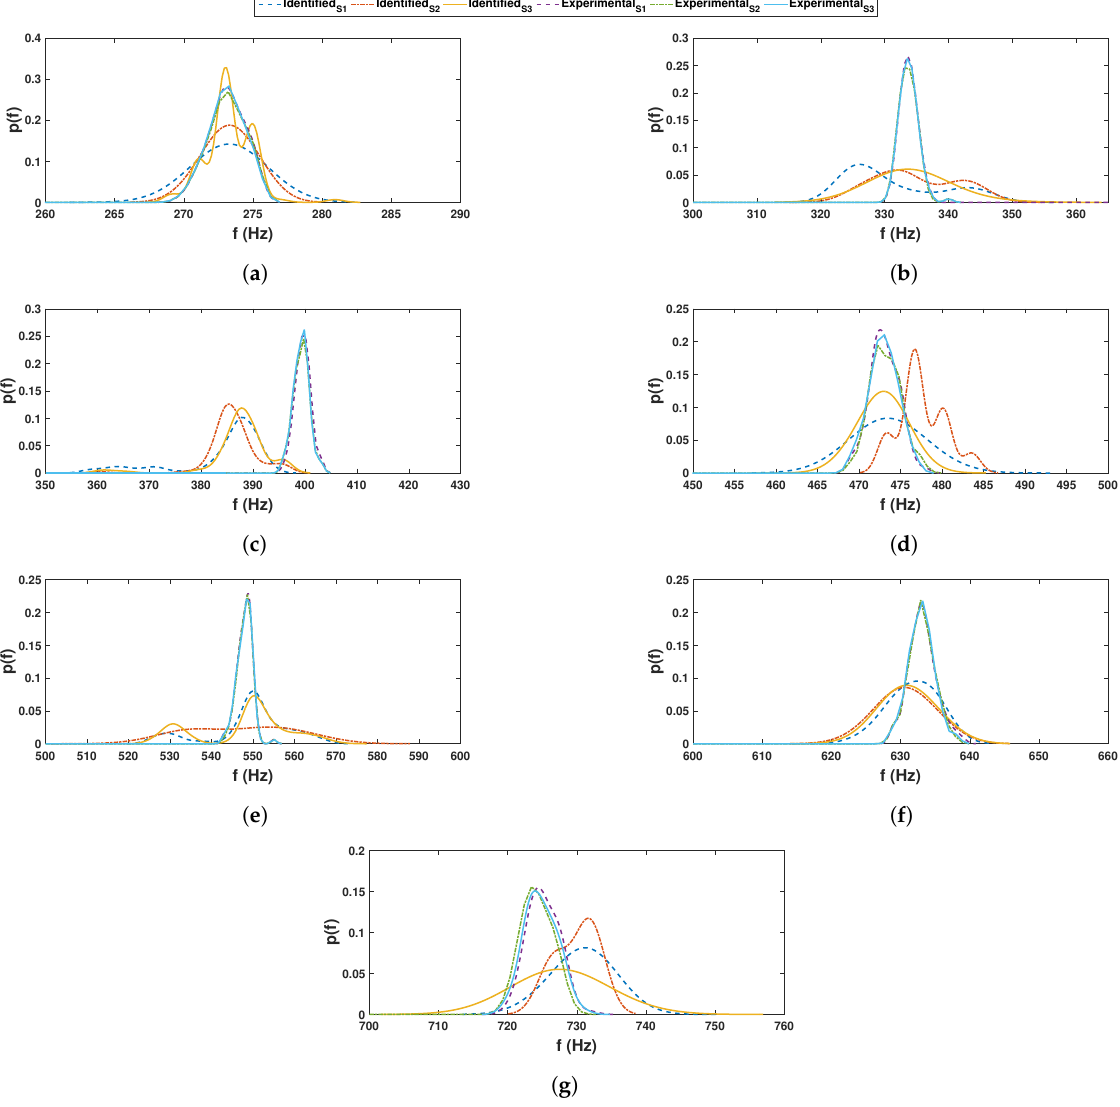
Figure 14. Comparison of pdf of identified and experimental cases for last 7 frequencies for beam